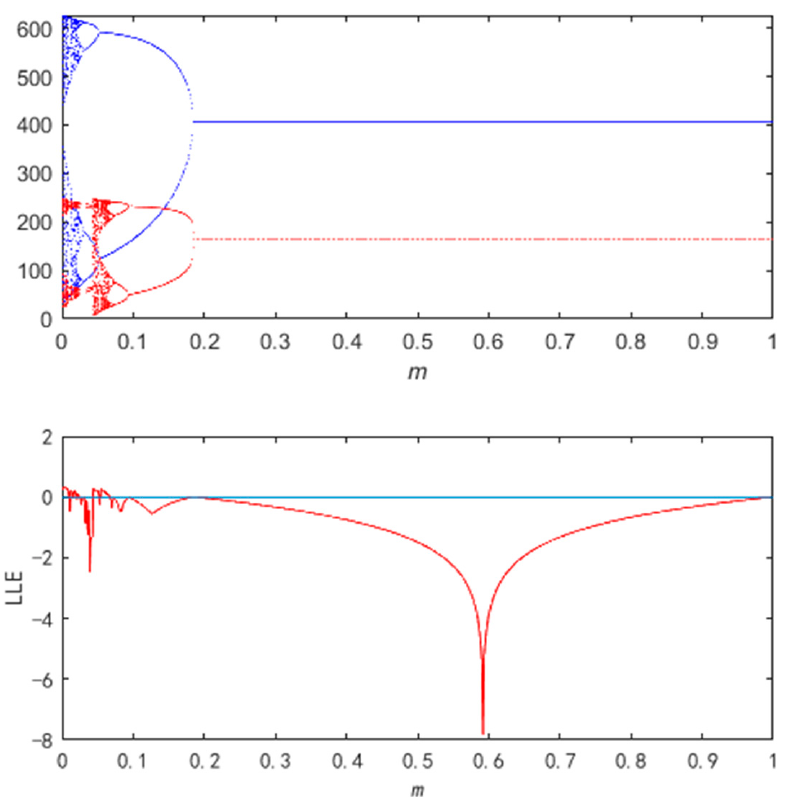
Figure 17. The bifurcation diagram of A m and A r and the largest Lyapunov exponent with respect to m .